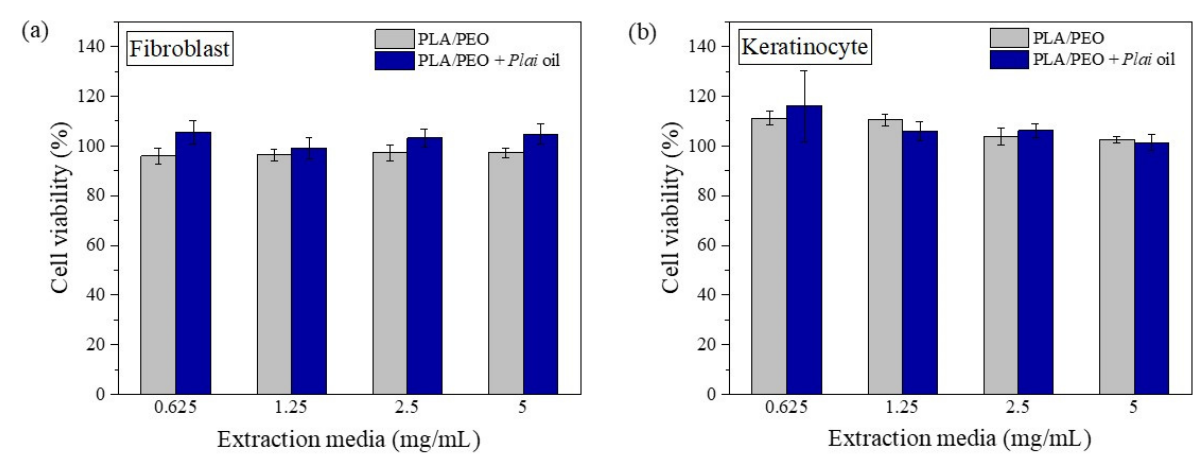
Figure 7. Cell viability (%) of ( a ) human dermal fibroblast and ( b ) human keratinocyte after 24 h exposure to the different concentrations of extraction media of the PLA/PEO and Plai oil-loaded PLA/PEO fiber blend membranes.